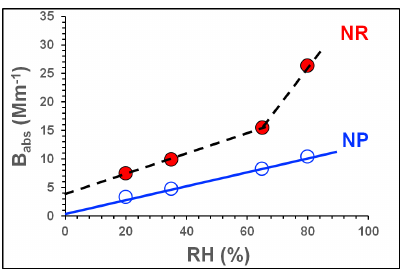
Figure 3. B abs as a function of RH in the NP and NR SOA formation regimes. NP (empty) and NR (filled) symbols are blue and red coloured, respectively. The solid and dashed lines are included to guide the